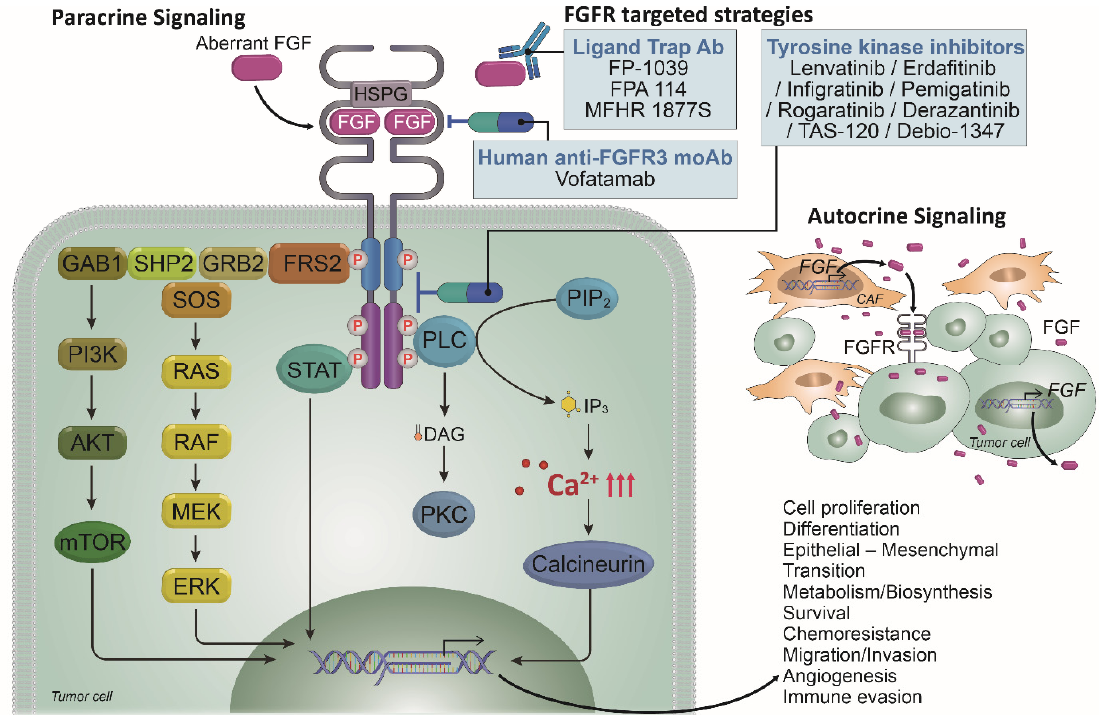
Figure 2. Multifaceted roles of FGFR signaling pathways in a/m UBC and therapeutic strategies. In conjunction with heparin sulfate proteoglycan (HSPG), the receptors bind FGF ligands, leading to receptor dimerization and autophosphorylation and the specific phosphorylation site can bind and phosphorylate substrate proteins to activate multiple signal transduction pathways. FGFR dimerization, kinase activation and trans-autophosphorylation lead to context-dependent activation of downstream signaling pathways. FGFRi reduces phosphorylation of FGFRs themselves and their direct targets, FRS2 and PLC- γ , and inactivate downstream signaling, such as the RAS-ERK, PI3K-AKT, IP3-Ca 2+ and DAG-PKC signaling cascades. Red upper arrow = an increase in cytosolic concentration